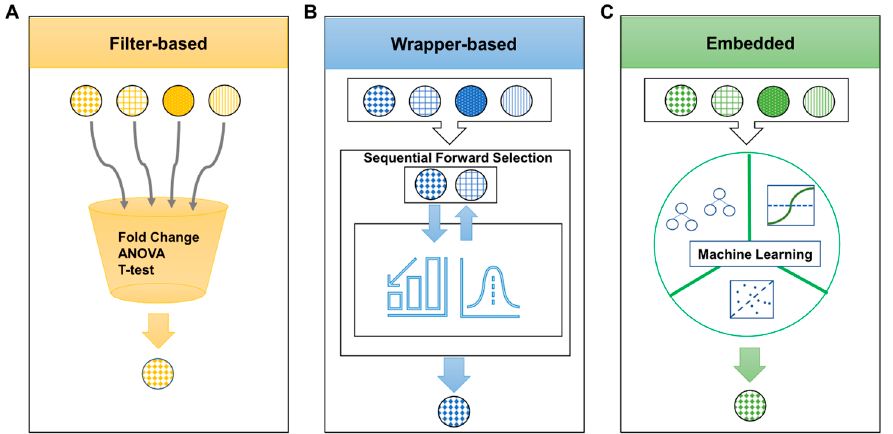
Figure 6. Schematic of three different feature selection methods for determining optimal protein biomarkers. ( A ) Filter-based methods are based on choosing the differential feature according to discriminating metrics such as p -value. Metrics are calculated from a statistical method such as fold change, ANOVA, and Student’s t -test. This method ranks proteins according to the selected criteria that put highly redundant or differentially expressed proteins on the top rank. ( B ) Wrapper-based methods look for the best subset of features based on their predictive power. Generation of a feature subset and assessment function is repeated until the optimal subset is returned through the learning algorithm. The feature subset with the highest performance is returned as a result. Sequential forward selection is one of the examples of this method and uses a bottom-up search technique to find the best subset. ( C ) Embedded methods use various machine learning techniques to select the optimal subset of features. Random forest, support vector machine and artificial neural network are examples of embedded feature selection methods.